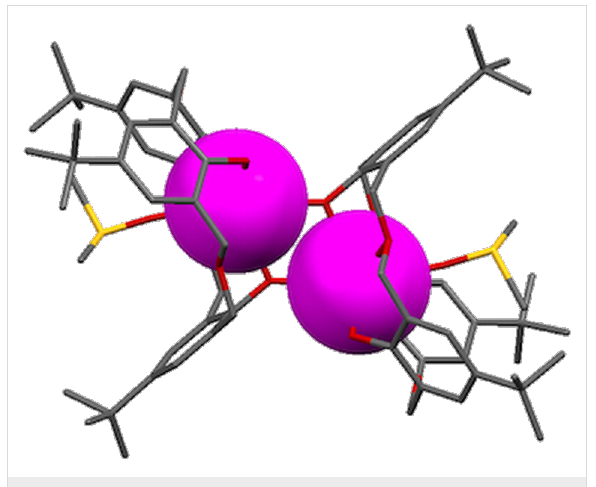
Figure 17: X-ray crystal structure of the La 2 · 3a 2 complex (CSD ID TIXXUT) [60].